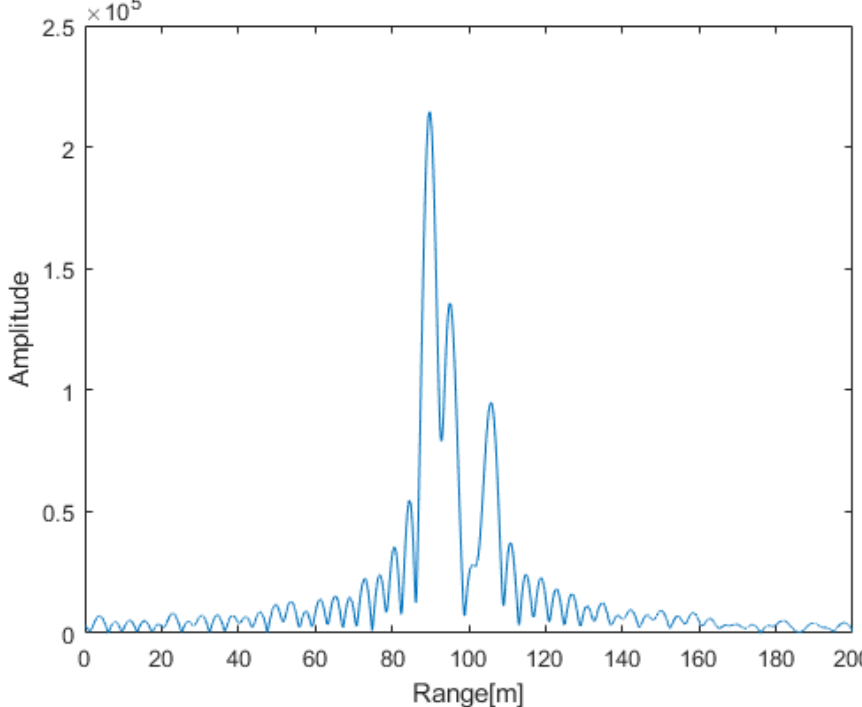
Figure 9. Pulse compression result received by conjugate